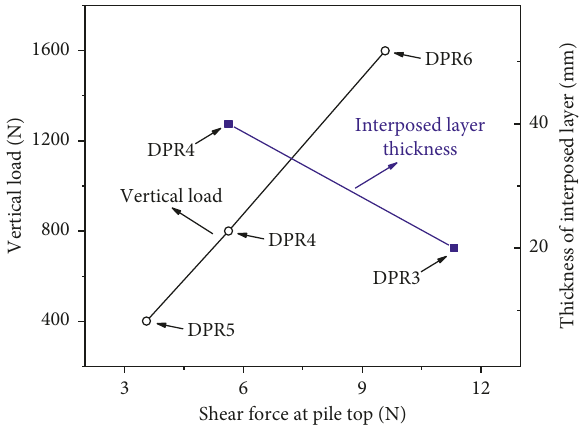
Figure 11: Shear force at the pile top versus interposed layer thickness and vertical